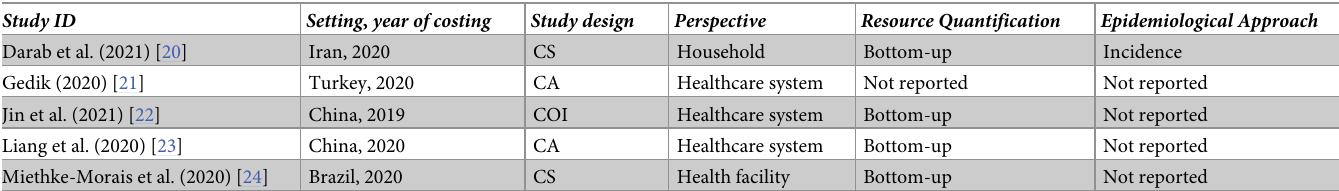
Table 1. Characteristics of included studies (COVID-19 hospitalization